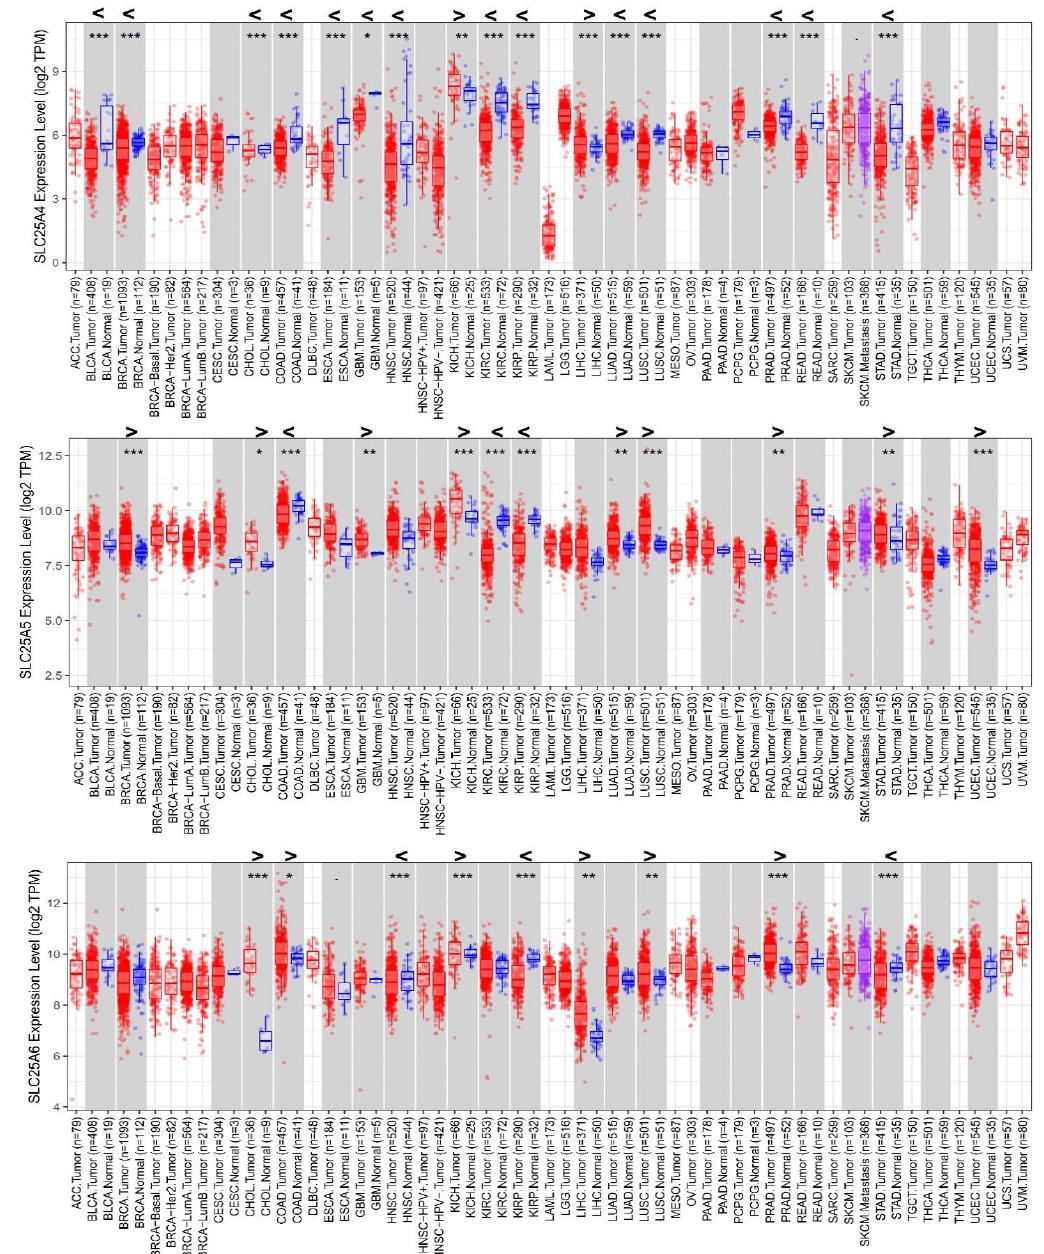
Figure 1. SLC25A4_AAC1 , SLC25A5_AAC2 , SLC25A6_AAC3 expression levels in 21 “cancer vs. normal” tissue pairs available on TCGA, analyzed through Timer2. The 21 “cancer (red box plots) vs. normal (blue box plots)” tissue pairs are reported and displayed on a grey background. Cancer tissues without a normal counterpart are reported and displayed on a white background. The violet box plot indicates AAC expression levels in the metastatic SKCM tissue within the “tumor/metastasis” SKCM tissue pair. For a list of the abbreviations, please see https://gdc.cancer.gov/resources-tcga-users/tcga-code-tables/tcga-study-abbreviations. The Gene_Differential Expression (DE) module allows users to study the differential expression between tumor and adjacent normal tissues for any gene of interest across all TCGA tumors. Distributions of AAC gene expression levels are displayed using box plots. The statistical significance computed by differential analysis (edgeR) on RNA-Seq raw counts is annotated by the number of stars (*: p -value < 0.05; **: p -value < 0.01; ***: p -value < 0.001). Readers can identify upregulated (>) or downregulated (<) AAC genes in the tumors compared to normal tissues for each cancer type, as displayed in gray highlighted columns when normal data are available. The “n” values reported below the boxplots refer to the number of patients whose cancer/normal tissue sample pairs are available in the TCGA